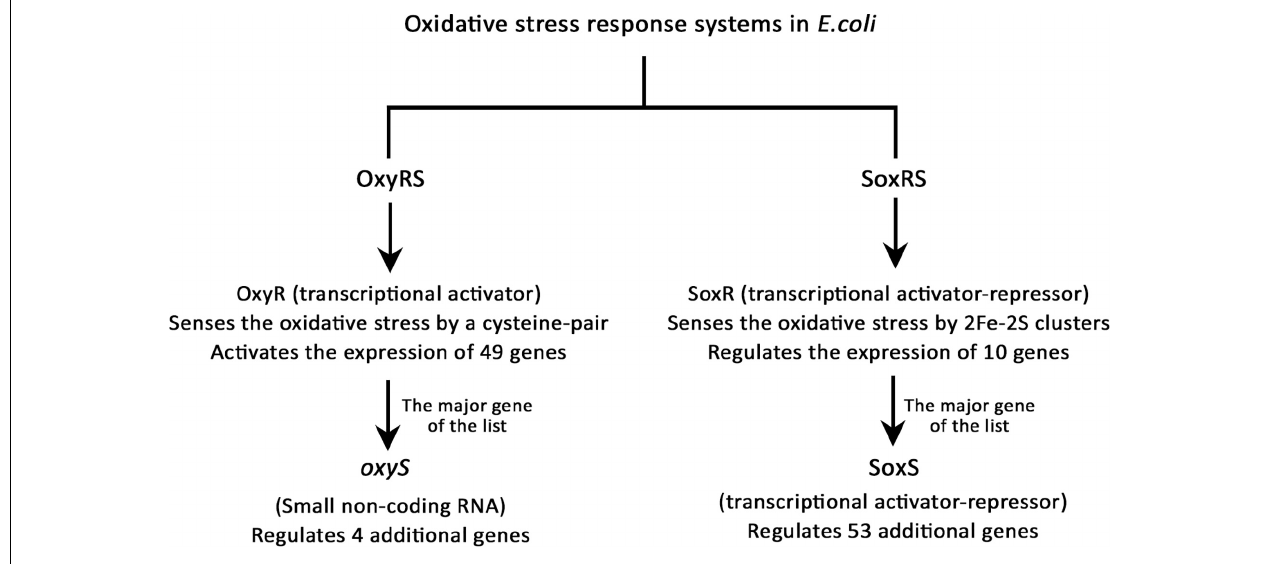
FIGURE 6 | The oxidative stress response systems in E. coli